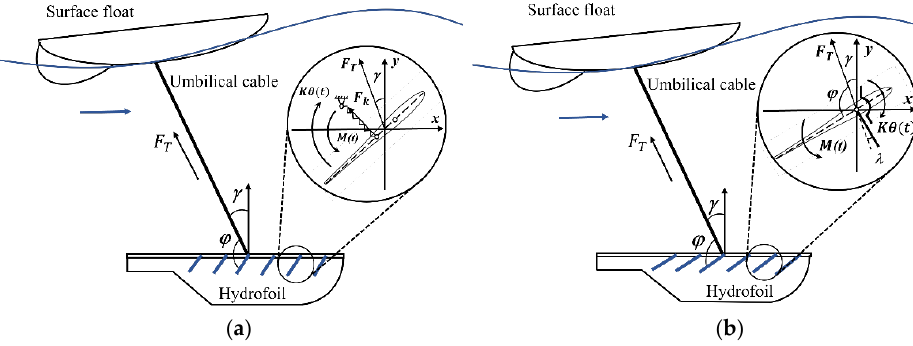
Figure 3. The hydrofoil comparison of the SALL submerged glider and the conventional submerged glider during ascent phase. ( a ) Conventional submerged glider; and ( b ) self-adjusting lower-limit submerged glider.